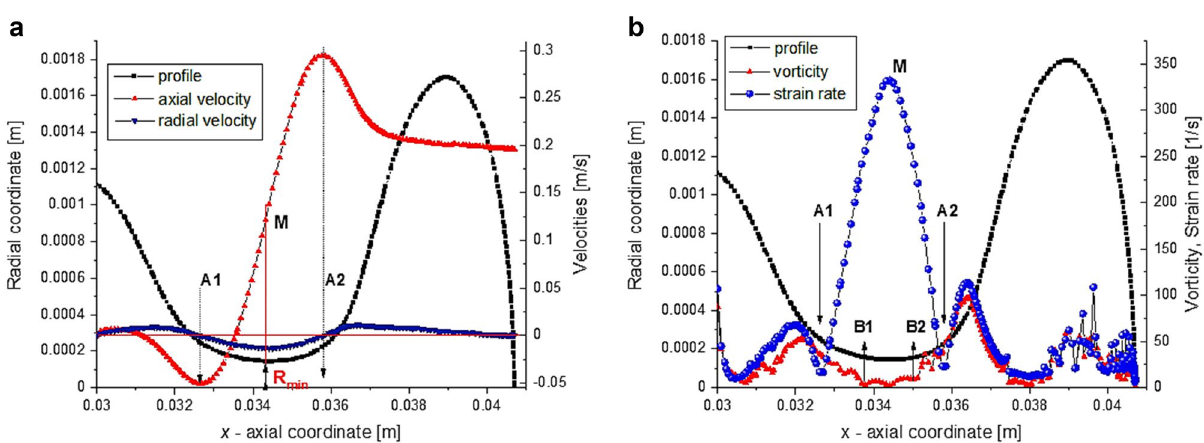
Figure 7. ( a ) Velocity components, ( b ) the vorticity and strain rate, along the droplet interface at time t = 81 ms